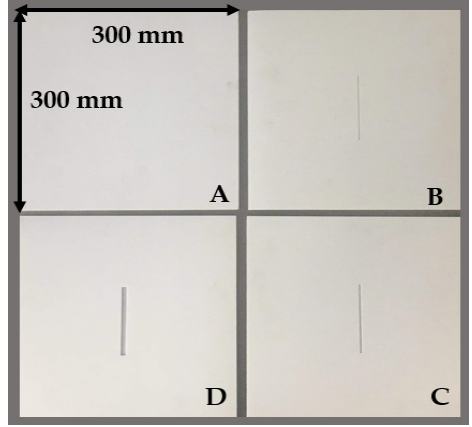
Figure 10. Photograph of the PTFE samples used for the test. Sample A is the non-cracked sample. The crack width of sample B is 1 mm. The crack width of sample C is 3 mm. Finally, the crack width of sample D is 7 mm.